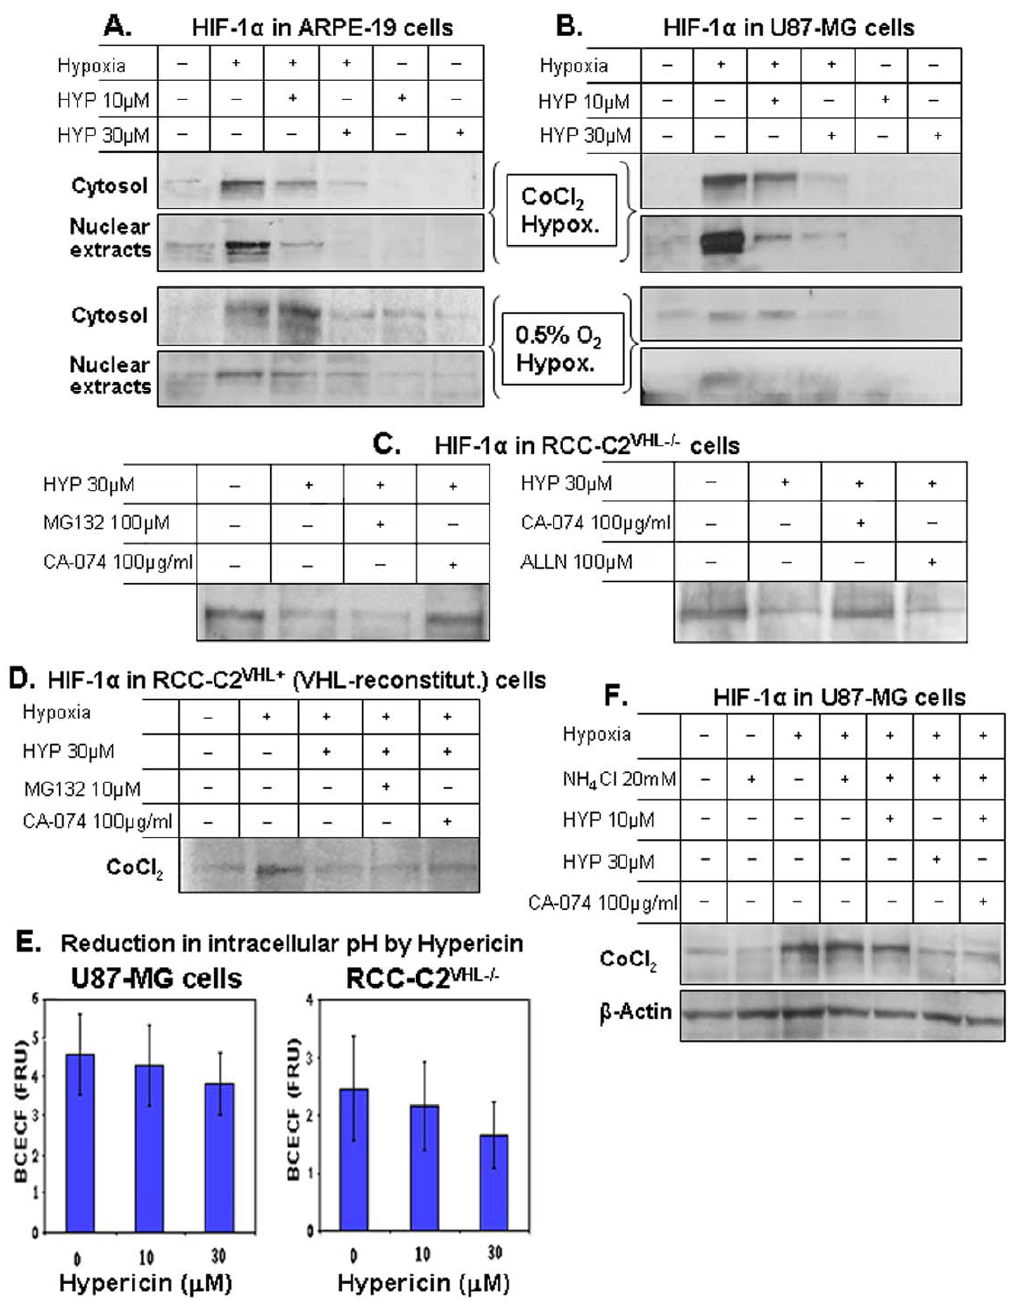
Figure 1. Enhancement of HIF-1 a turnover under hypoxic conditions in cells exposed to hypericin. [A] ARPE19, [B] U87-MG, [C] RCC- C2 VHL 2 / 2 and [D]. RCC-C2 VHL + (VHL gene reconstituted) cell lines were exposed to 10 and 30 m M hypericin for 72 hrs. The cultures were subjected to hypoxic conditions with 150 m M CoCl 2 (A & B, upper panel doublets) and with a low oxygen atmosphere (0.5% O 2 , 94.5% N 2 and 5% CO 2 ) (A & B, lower panel doublets) for the last 6 hours of treatment. Hypericin caused degradation of HIF-1 a . The mediator of HIF-1 a proteolytic cleavage was characterized by inhibition of HIF-1 a degradation with the CA-074 cathepsin B inhibitor, with MG-132 and with ALLN proteasomal calpain inhibitors, administered to the cultures for the last 6 hours of incubation with the cells. Cytosolic extracts and nuclear extracts were prepared, separated on SDS- PAGE and Western blots developed with anti-HIF-1 a . Equal loading was confirmed with b -Actin. [E]. Effects of hypericin on the intracellular pH of U87- MG and C2 VHL 2 / 2 cells. Quantitative BCECF, pH-dependent fluorescence was measured spectrofluorimetrically (FRU denotes Fluorescence Relative Units). [F]. Analysis of the role of hypericin-mediated intracellular pH reduction in promoting HIF-1 a turnover under CoCl 2 hypoxia, determined following cytoplasmic alkalinization with 20 mM NH 4 Cl applied during the last 6 hrs of incubation. Cytoplasmic alkalinization diminished the hypericin-induced HIF-1 a turnover under CoCl 2 hypoxia.